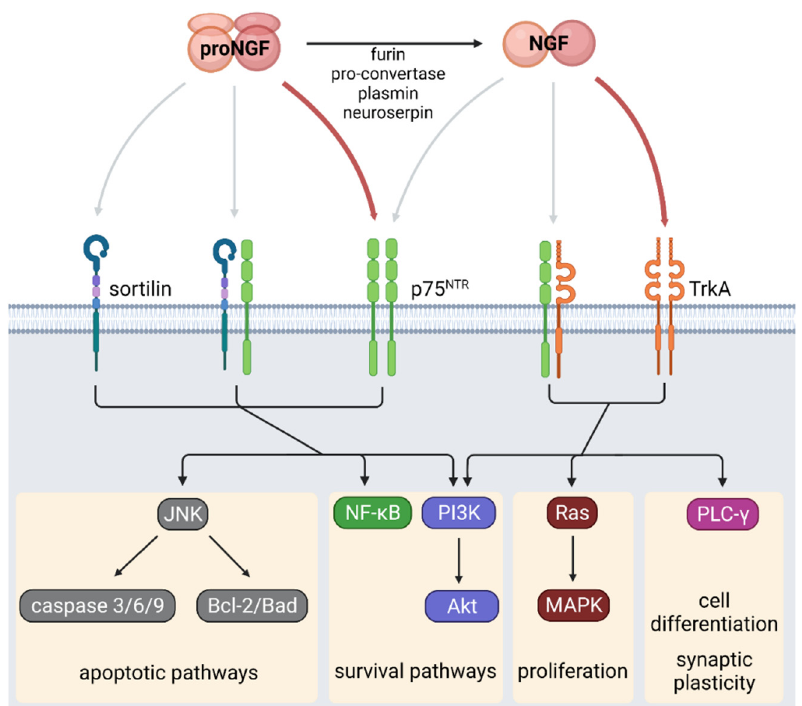
Figure 1. NGF signaling. NGF is synthesized as the precursor proNGF, which is cleaved by different proteases producing mature NGF. ProNGF binds with high affinity to the p75 NTR receptor while NGF preferentially binds to TrkA receptor. The local proNGF/NGF ratio determines the activation of apoptotic, cell survival, proliferation, or differentiation signaling pathways in different